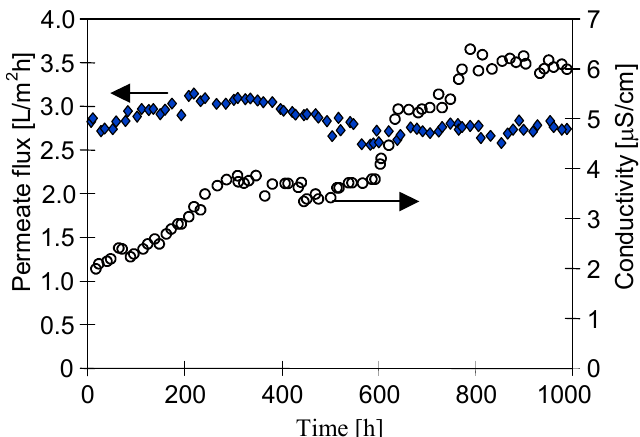
Figure 12. The changes of permeate flux and distillate conductivity during the MD process. Feed: lake water, T F = 313 K. Module MK1B—Accurel PP S6/2.